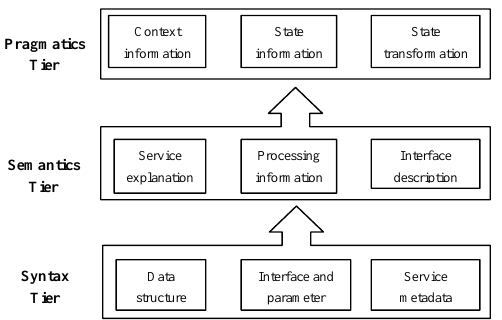
Figure 1.Main ingredients and relations of three